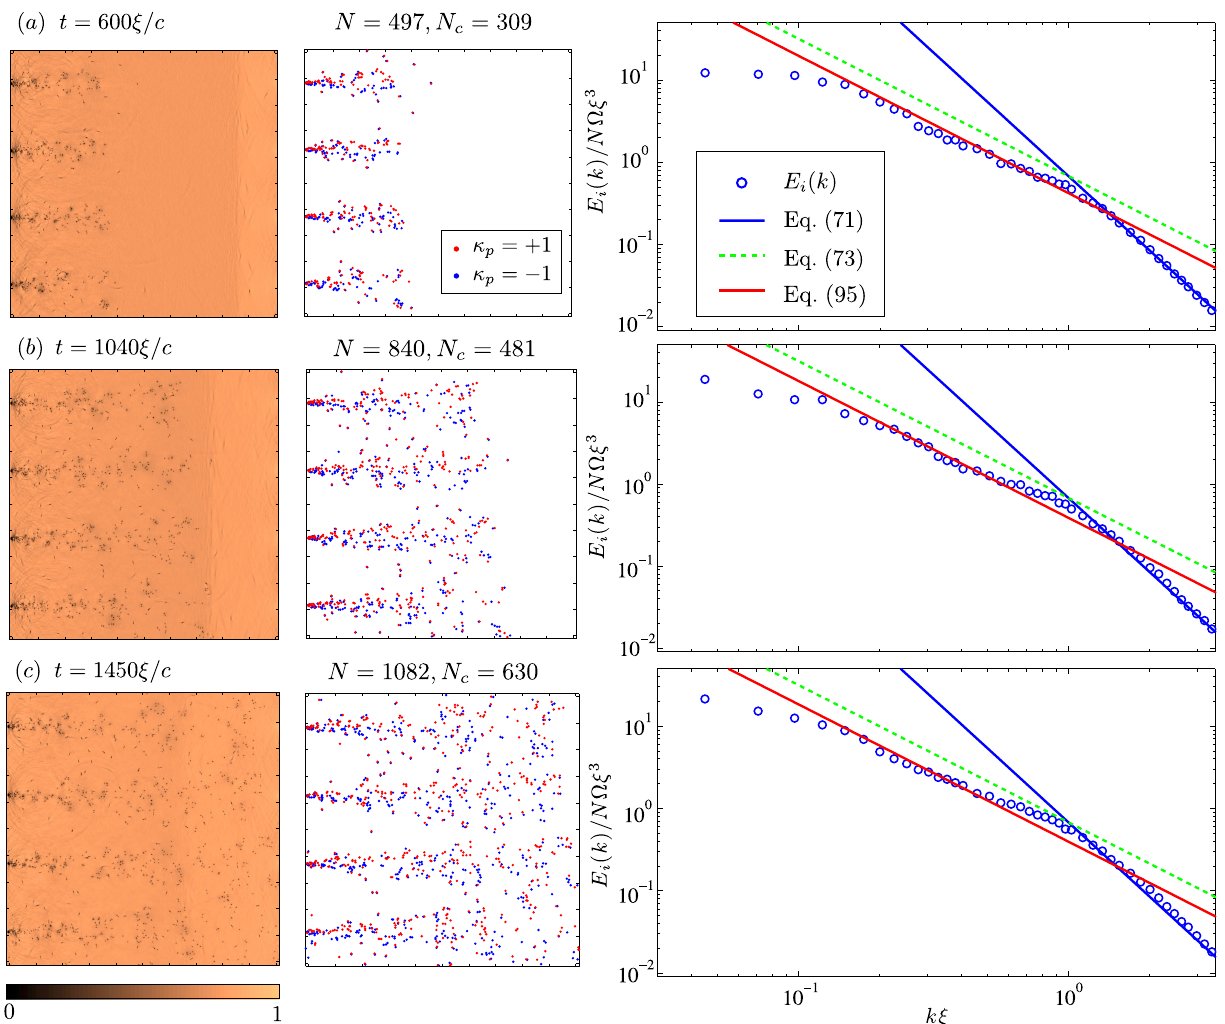
FIG. 7. Time evolution of grid turbulence in damped GPE. Left: Particle density (rescaled to the peak density). Center: Vortices ) numbers of vortices. The field of view is ð 1024 (cid:1) Þ 2 . Right: Incompressible energy colored by charge, with total ( N ) and clustered ( N c spectra (circles), with the Kolmogorov ansatz [Eq. (95), red line], the ansatz for a polarized cluster of N vortices [Eq. (73), dashed line], and the universal k (cid:2) 3 region [Eq. (71), blue